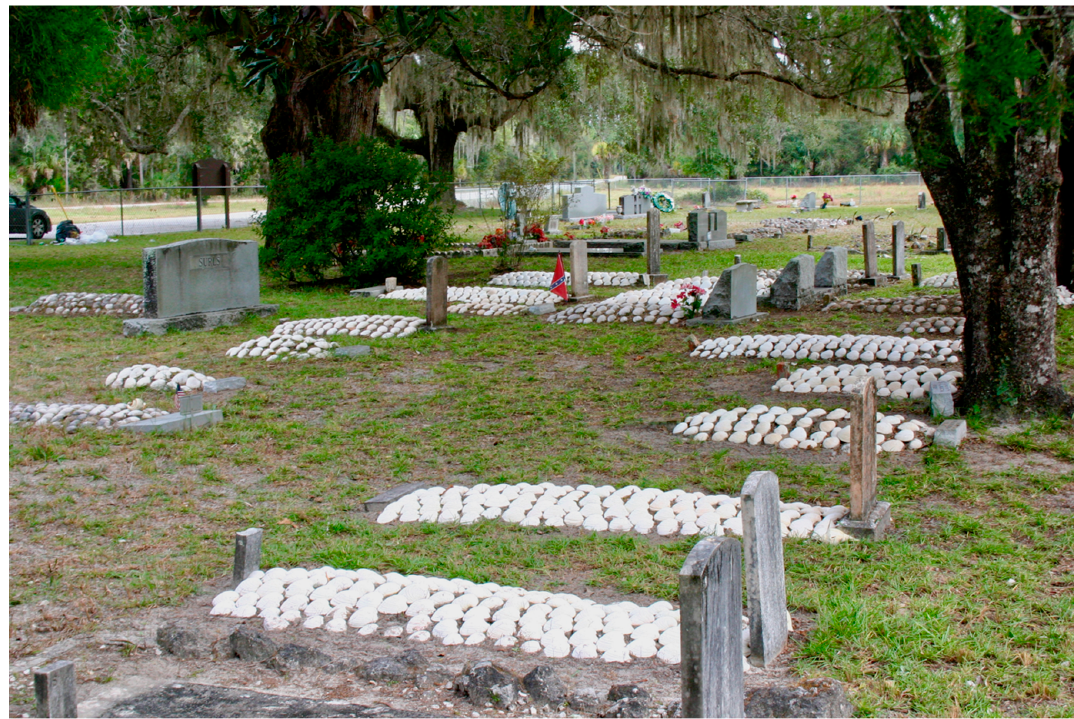
Figure 3. Photograph of the cemetery, in which recently bleached shells carefully arranged atop many of the graves. Photograph courtesy of the author.